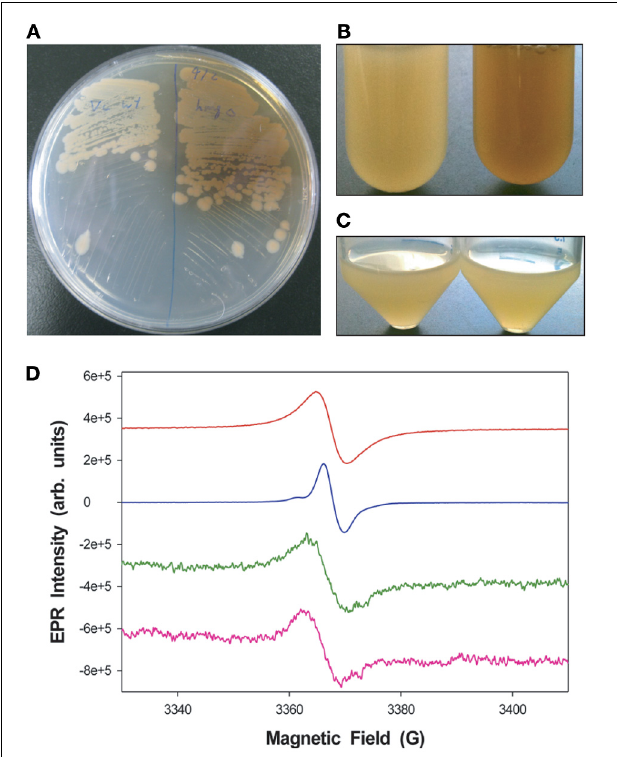
FIGURE 1 | Pigmentation differences between V. campbellii WT and (cid:2) hmgA . (A) Colonies grown on LM agar. WT (left), (cid:2) hmgA (right); (B) Cell cultures grown in LM in borosilicate glass tubes (48 h). WT (left), (cid:2) hmgA (right); (C) Cell cultures grown in LM in polypropylene conical tubes (48 h). WT (left), (cid:2) hmgA (right); (D) EPR spectra of synthetic melanin (red), DHN-melanin (blue) and partially purified pigments from the supernatants of two independent (cid:2) hmgA cultures (green and pink).